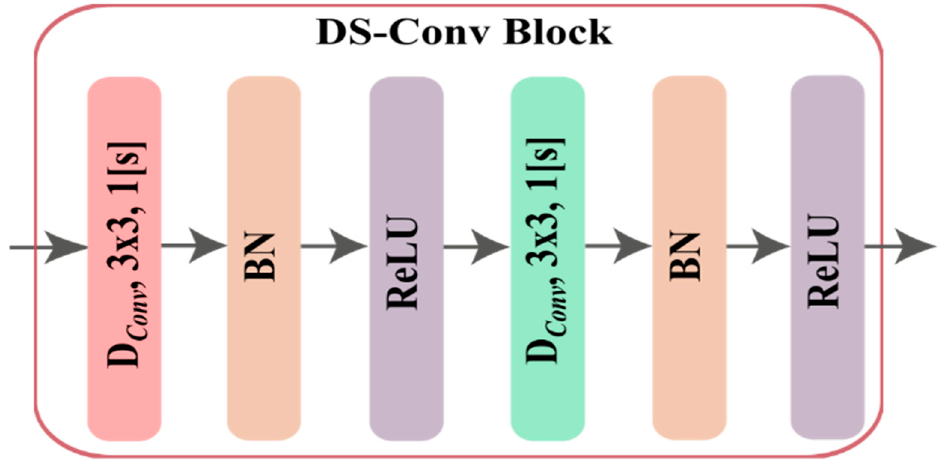
Figure 4. Block diagram of DS-Conv